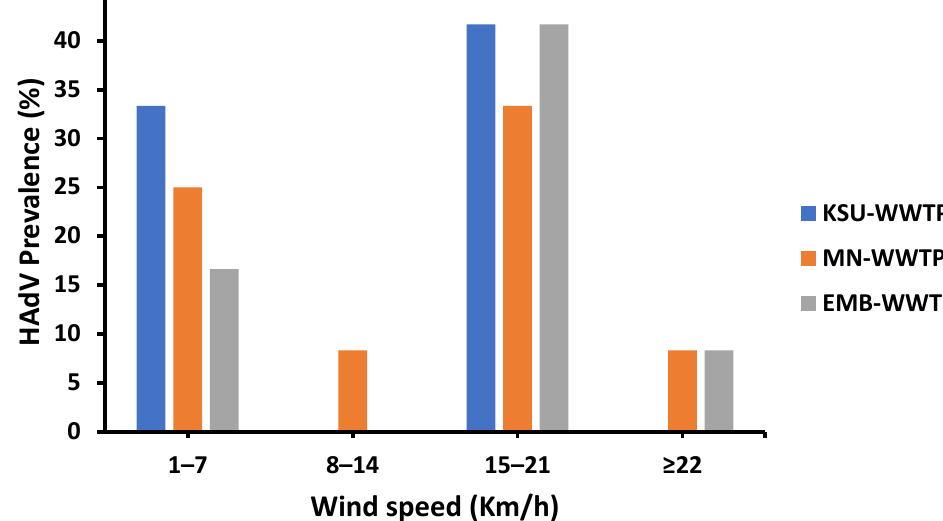
Figure 8. Impact of wind speed ranges (km/h) on the HAdV prevalence (%) in different sampling areas.